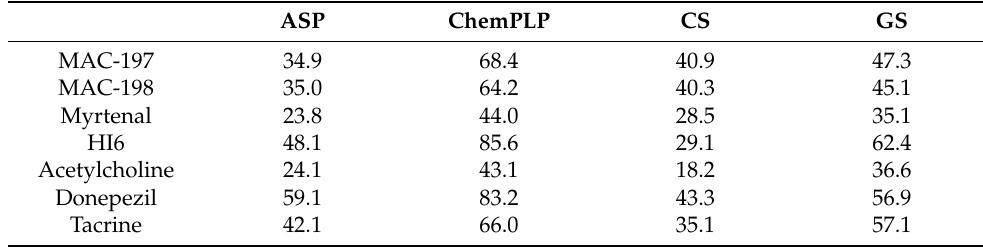
Table 2. The binding affinities to the catalytic site of AChE as predicted by the scoring functions GoldScore (GS), ChemScore (CS), ChemPiecewise Linear Potential (ChemPLP), and Astex Statisti- cal Potential (ASP) using GOLD (v5.4.1) (Cambridge, UK). HI6 is the co-crystallized ligand (4-(aminobarbonyl)-1-[({2-[( E )-(hydroxyimino)methyl]pyridiunum-1-yl}methoxy) methyl]pydidinium).